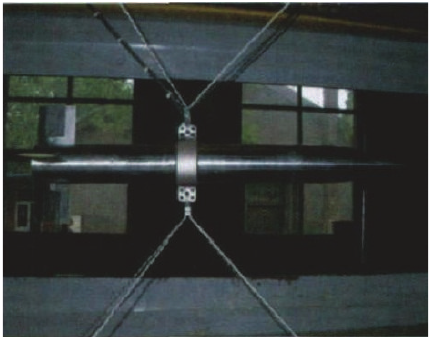
Figure 26: The first VFT system built by CAAA in China [118].